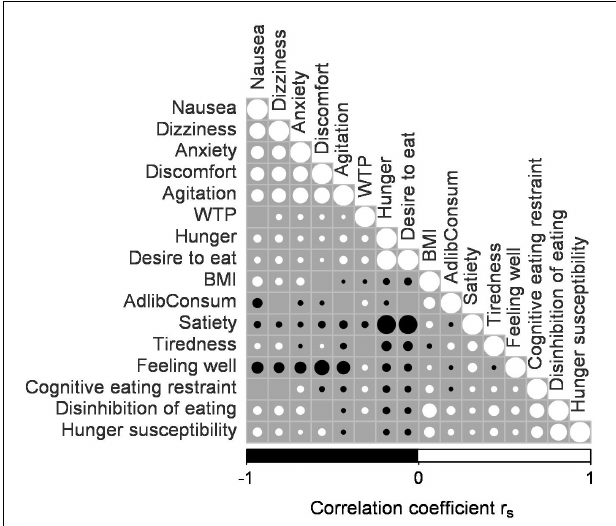
FIGURE 1 | Correlation matrix of willingness to pay (WTP), ad libitum consumption level, BMI, Three-Factor Eating Questionnaire (TFEQ) scores, and subjective state ratings. This correlation matrix displays the correlation of WTP, BMI, ad libitum consumption level, TFEQ Cognitive eating restraint, TFEQ Disinhibition of eating, TFEQ Hunger susceptibility, nausea, dizziness, anxiety, discomfort, agitation, hunger, desire to eat, satiety, tiredness, and feeling well. See Results for further explanations. The diameter of the filled and open circles are proportional to the correlation magnitude (r s ) where a large circle stands for a high r s . Open circles indicate positive correlation, whereas filled circles indicate negative correlations. No circle is depicted at intersections where there was no significant correlation ( p >